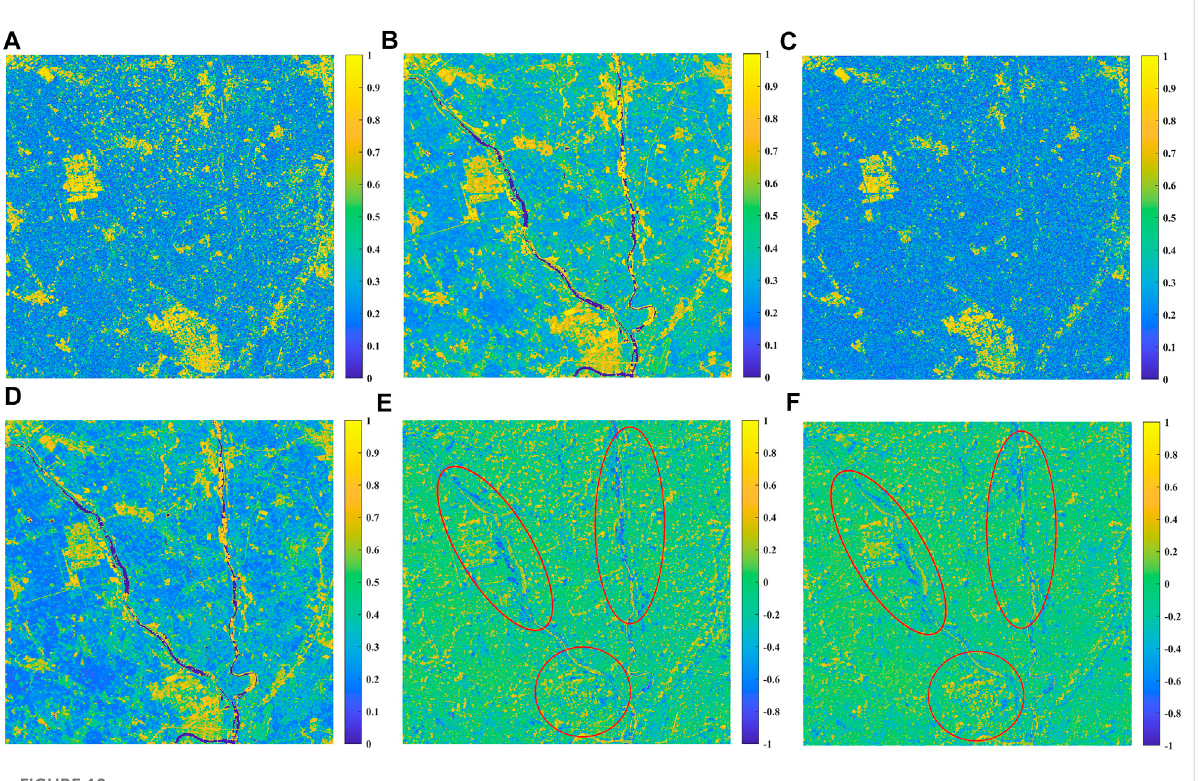
FIGURE 10 CoherenceimagesofthevalidationA (A) TrueatVVchannel (B) EstimationatVVchannel (C) TrueatVHchannel (D) EstimationatVHchannel (E) Differences distribution at VV channel (F) Differences distribution at VH channel.